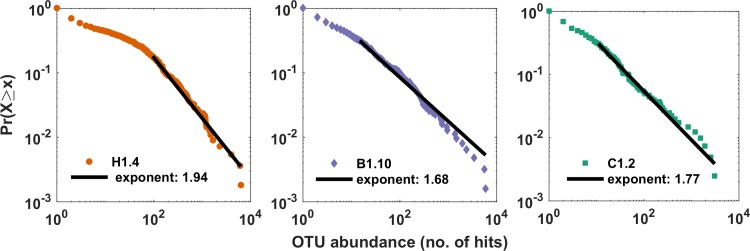
Representative power laws from sample genus abundance distributions for (A) hotspots (B) background and (C) coldspots.